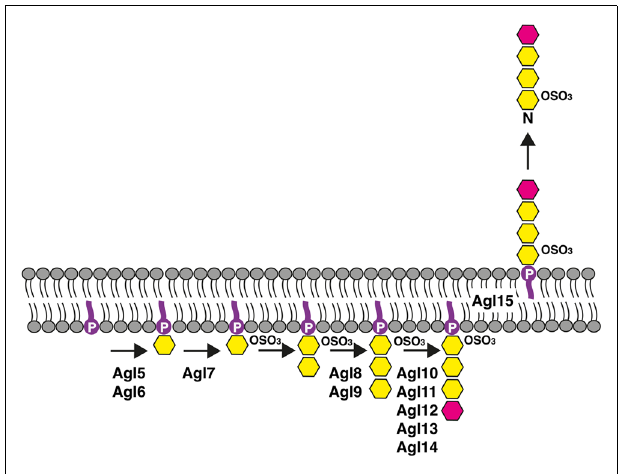
FIGURE 2 | Schematic depiction of the Hfx. volcanii pathway used for the assembly of the tetrasaccharide N-linked to the S-layer glycoproteinAsn-498 position when the cells are grown in low salt (1.75 M NaCl)-containing medium. See the text for details. In the figure, dolichol phosphate is in purple, hexose is in yellow and rhamnose is in pink. The bottom half of the figure corresponds to the cell interior.